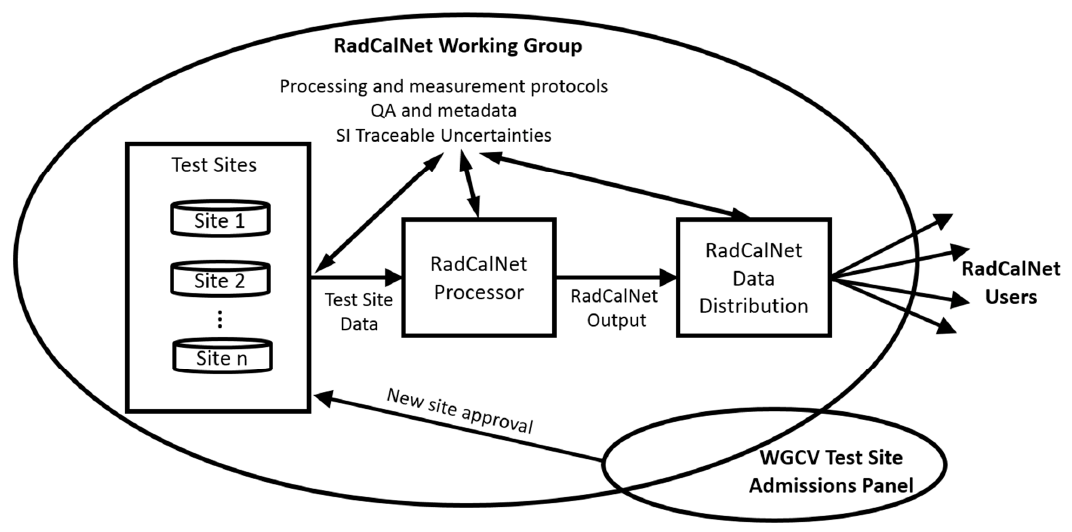
Figure 1. Overview of the RadCalNet (Radiometric Calibration Network) organization. WGCV: Working Group on Calibration and Validation.